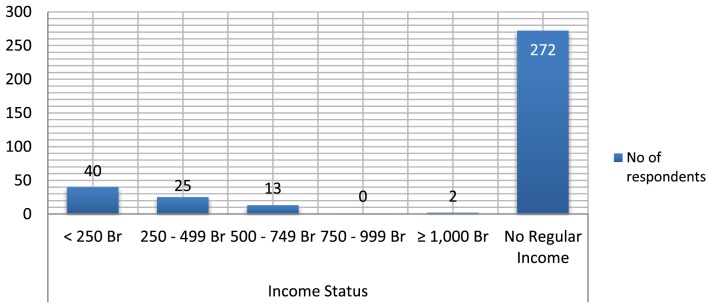
Income distribution of respondents and household members.